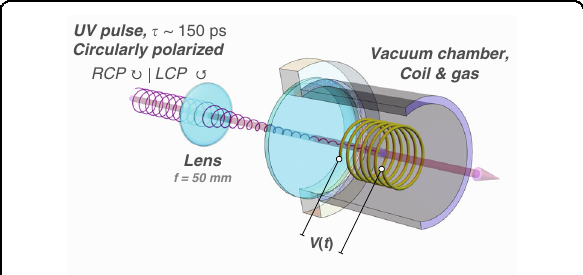
Fig. 2 Experimental setup for the detection of SPH with a pickup coil. A circularly polarized, 150 ps UV pulse (at 213 or 266 nm) is focused into a vacuum chamber containing hydrogen halide gas at 0.1 – 5 bar, and passes through the pickup coil, and produces the